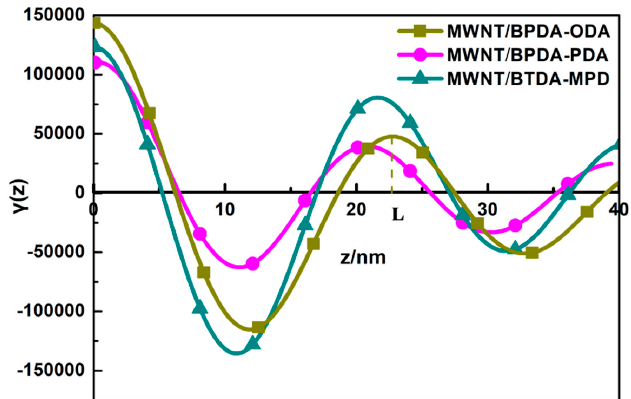
Figure 5. One-dimension electron density correlation function of three aligned MWNT / PI composites. Table 1. Statistical data of one-dimensional correlation function.